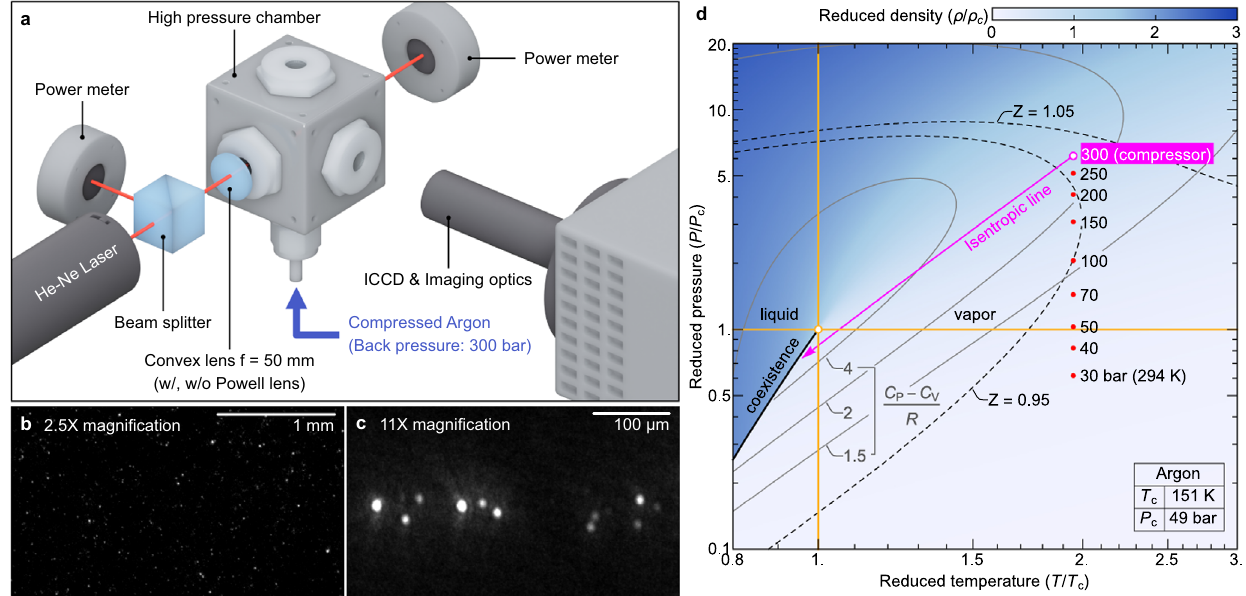
Fig. 1 Experimental apparatus and conditions. a Schematic of the high-pressure chamber system. The incident He – Ne laser (633 nm, 5 mW) has a beam waist radius of about 50 µ m at the focus. The incident laser is additively reshaped with a laser line generator (called the Powell lens) for the lower magni fi ed imaging optics. Imaging optics and intensi fi ed CCD (ICCD) capture the Rayleigh – Mie scattering signals from individual droplets. b, c Images of droplets with ×2.5 and ×11 magni fi cations at 100 bar. d Extended phase diagram of homogeneous and equilibrium argon fl uid. The red points indicate the experimental conditions. The working pressure of the compressor is 300 bar. The argon fl uid undergoes an adiabatic expansion to form the liquid droplets and clusters. The compressibility factor Z ¼ P = ρ RT which is unity for the case of an ideal gas. The thermophysical properties of argon are obtained from the NIST Chemistry WebBook 24 .